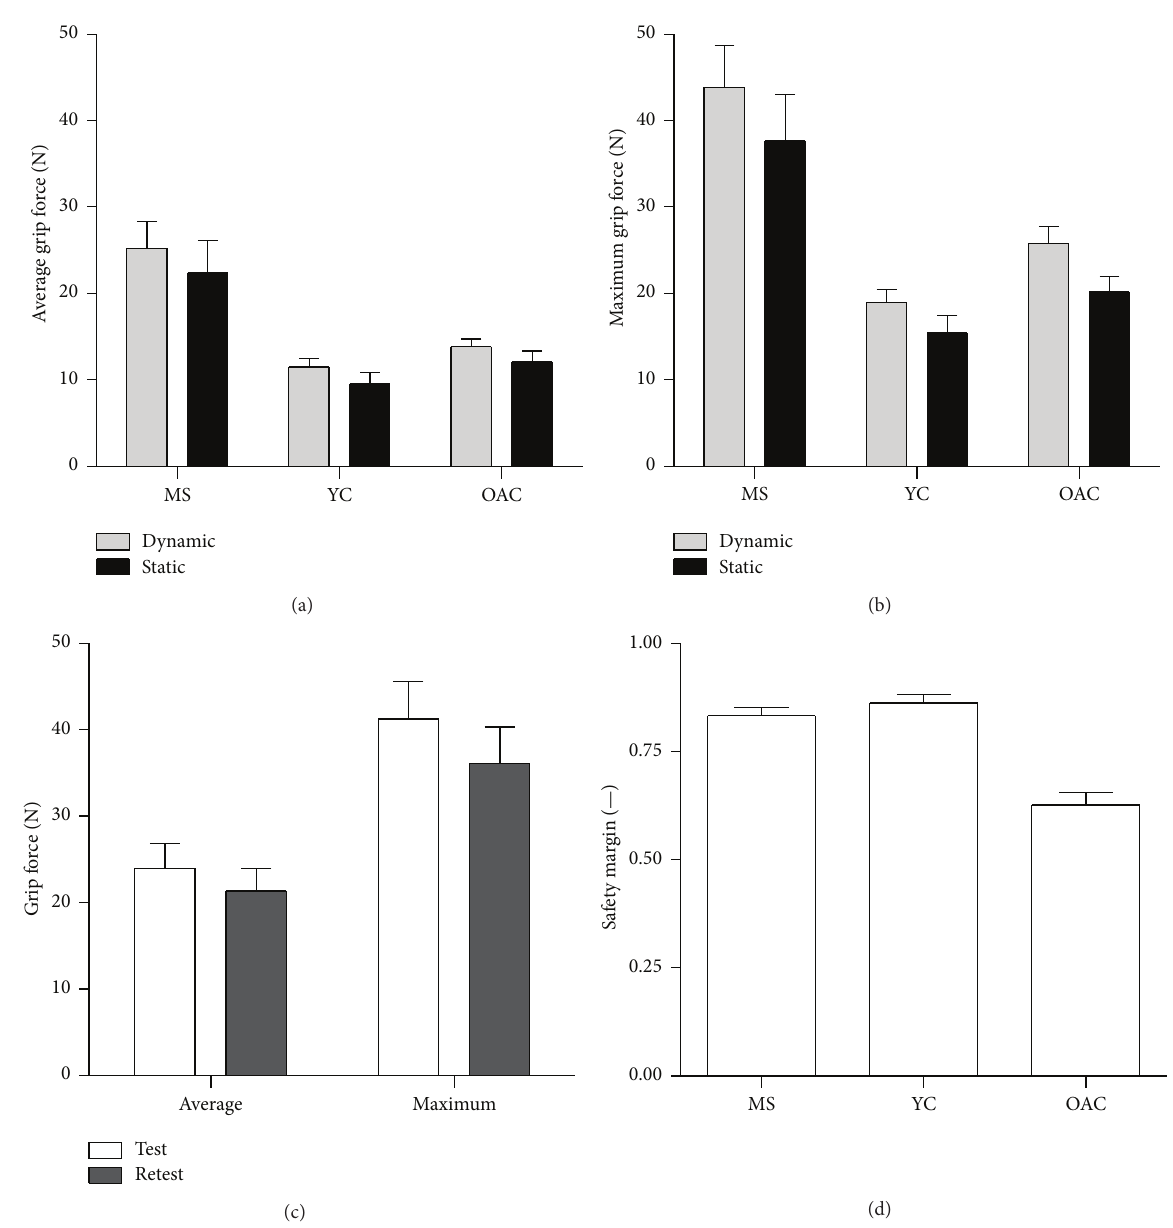
Figure 3: Mean and standard error of average grip force, maximum grip force, test-retest grip force values, and safety margins exerted. MS: multiple sclerosis group, YC: young control group, and OAC: older adult control group. (a) Average grip forces produced on the dynamic and static transducers. (b) Maximal grip forces produced on the dynamic and static transducers. (c) Grip force differences between test and retest sessions. (d) Safety margin values for each of the three diagnosis